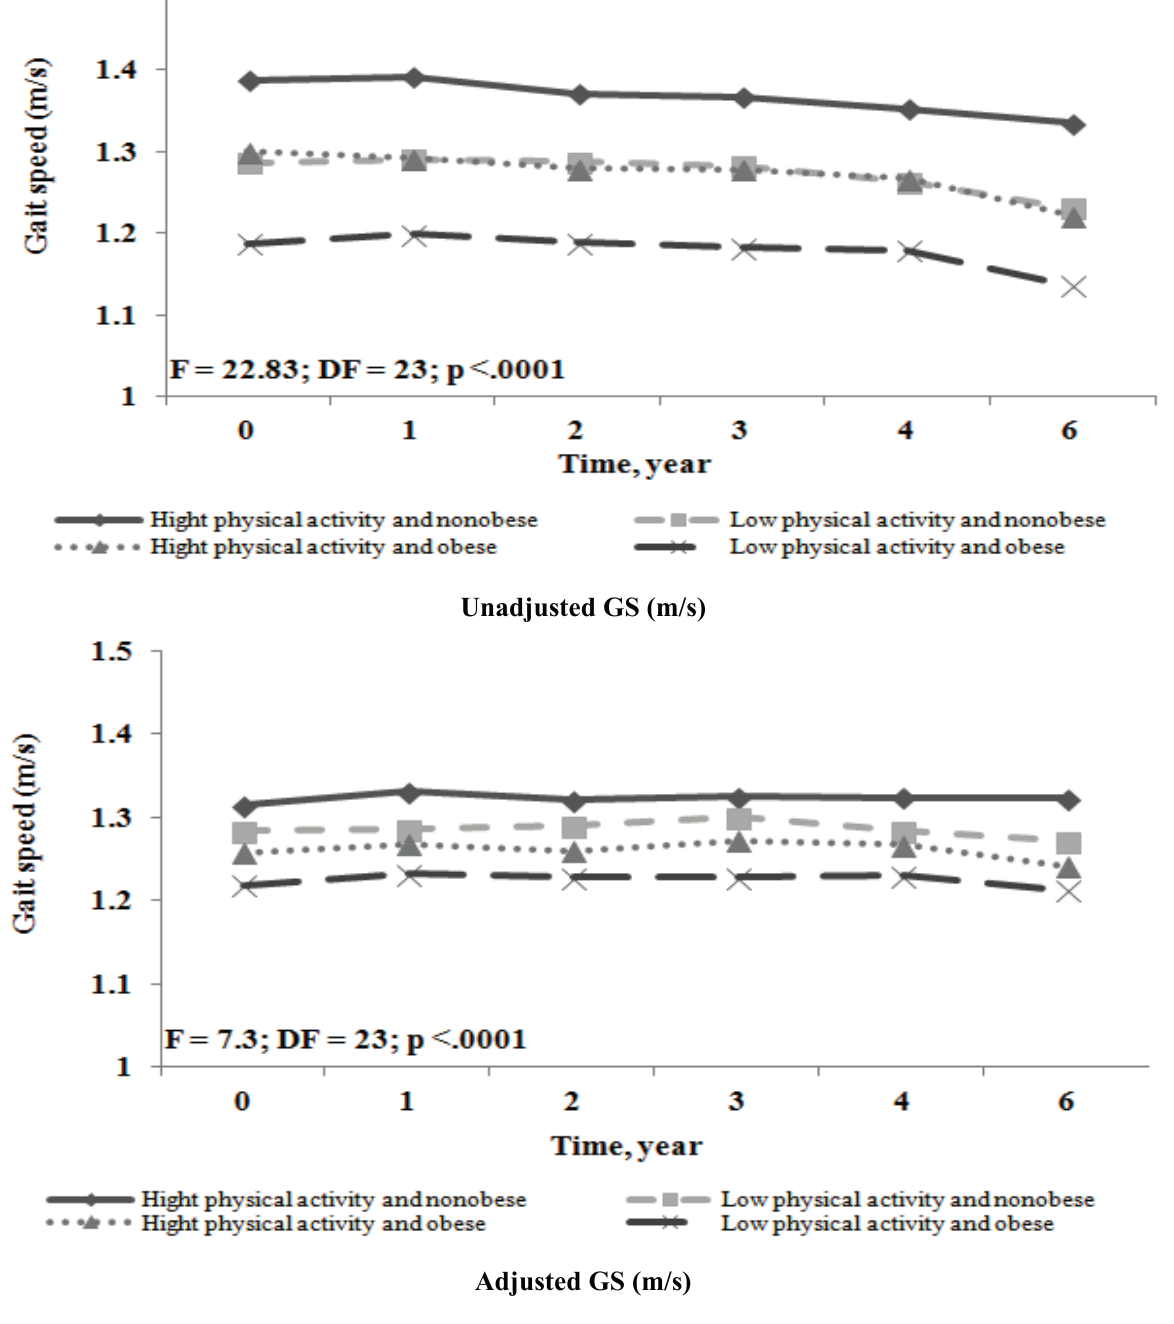
Figure 2. Unadjusted and adjusted GS over 6-year period in older adults with frequent knee pain (unadjusted GS (m/s) —older adult’s statistically significant, p < 0.0001; adjusted GS (m/s)—older adult’s statistically significant, p <